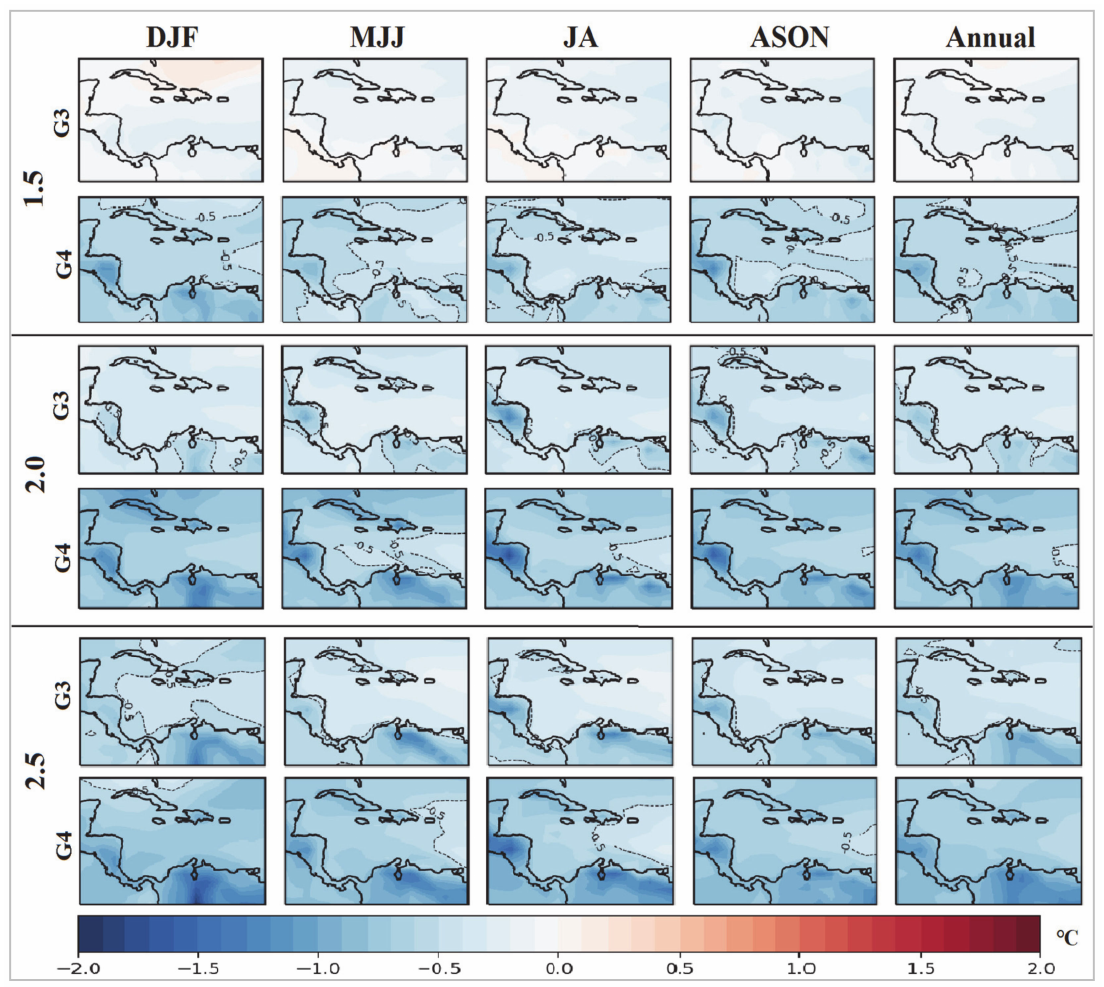
Figure 8. Difference maps of air temperature for G3 and G4 with respect to HadGEM2_unaltered. Differences are between composites derived for the 11-year periods centered on when HadGEM_unaltered indicates global average temperatures attain the 1.5, 2.0 and 2.5 ◦ C long-term temperature goals (LTTGs). Units are ◦ C. The ± 0.5 ◦ C contour is plotted for